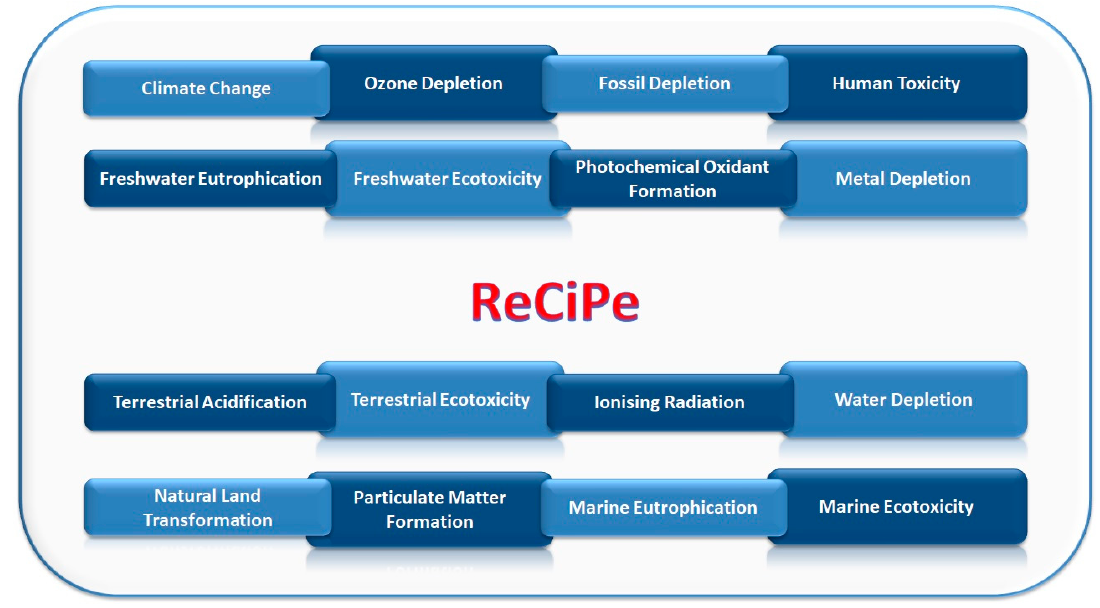
Figure 8. ReCiPe impact indicators.